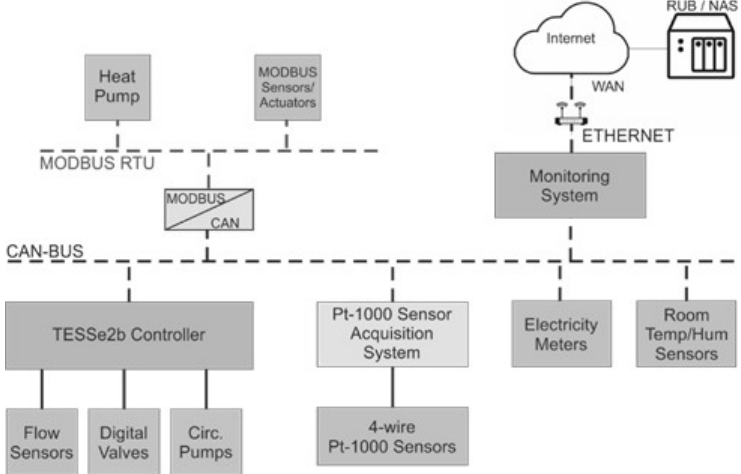
Figure 6. Overview of TESSe2b control and monitoring system implementation.